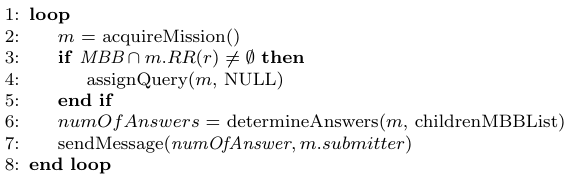
Algorithm 3 Subscribing MP Algorithm